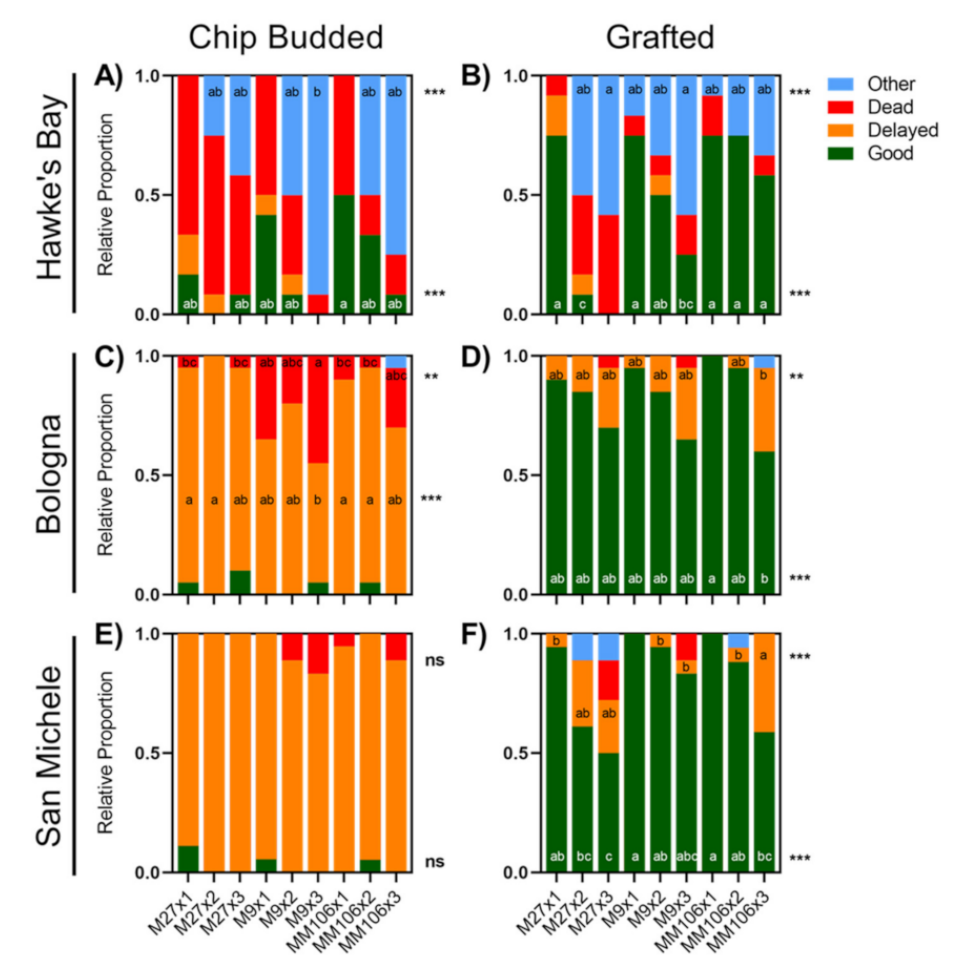
Figure 1. The interaction effect of ‘rootstock × axis number’ in chip-budded ( A , C , E ) and bench- grafted ‘Fuji’ trees ( B , D , F ) on the relative proportion of development trees grown in New Zealand ( A , B ), Bologna, Italy ( C , D ), and San Michele, Italy ( E , F ). Tree development classifications included: good development (green), delayed development (yellow), tree death (red), or developed a lesser number of axes required for the treatment (i.e., other, blue). On the X -axis, ‘rootstock × axis number treatments’ are listed. ANOVA significance is indicated to the right of each graph, labeled with **, ***, denoting where the model was significant at p < 0.01 and 0.001, respectively, across the two primary categories for each ‘site × propagation’ plate. ‘Rootstock × axis number treatment’ proportion means sharing the same letter are not significantly different according to Tukey’s post-hoc means comparison test at p <